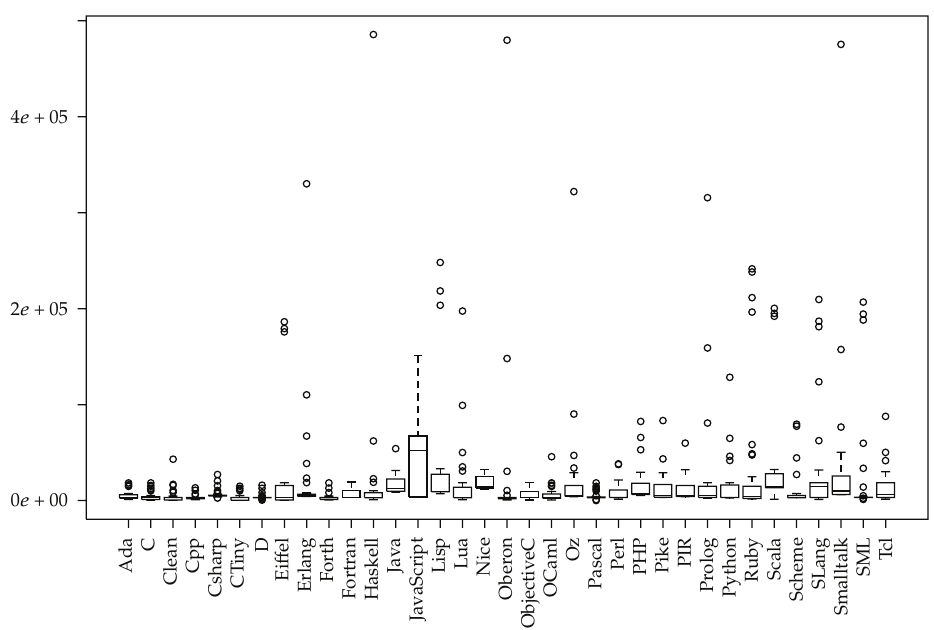
Figure 2: Distribution of the values of memory usage recorded for each